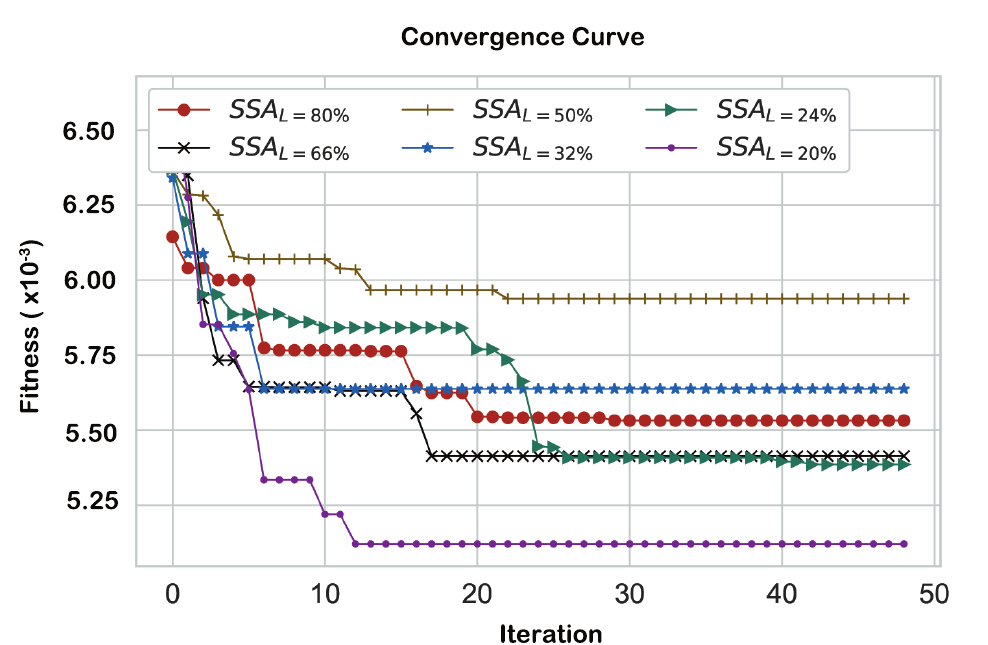
Figure 9. Convergence curves of the SSA algorithm at different ratios of leaders.